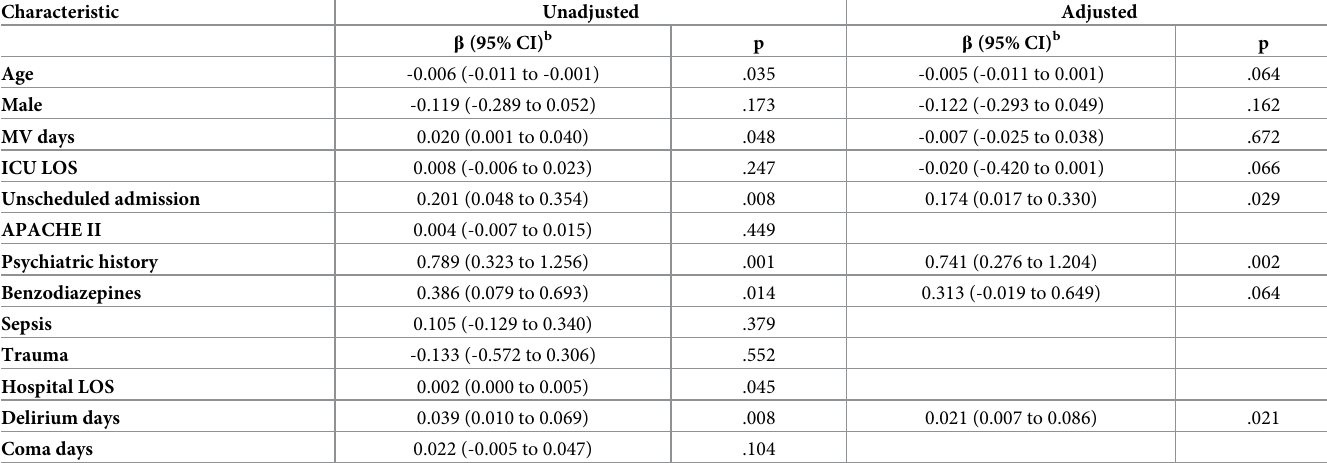
Table 2. Risk factors of the severity of post-traumatic stress disorder symptoms a in univariable and multivariable analyses using a multilevel linear regression model. Characteristic